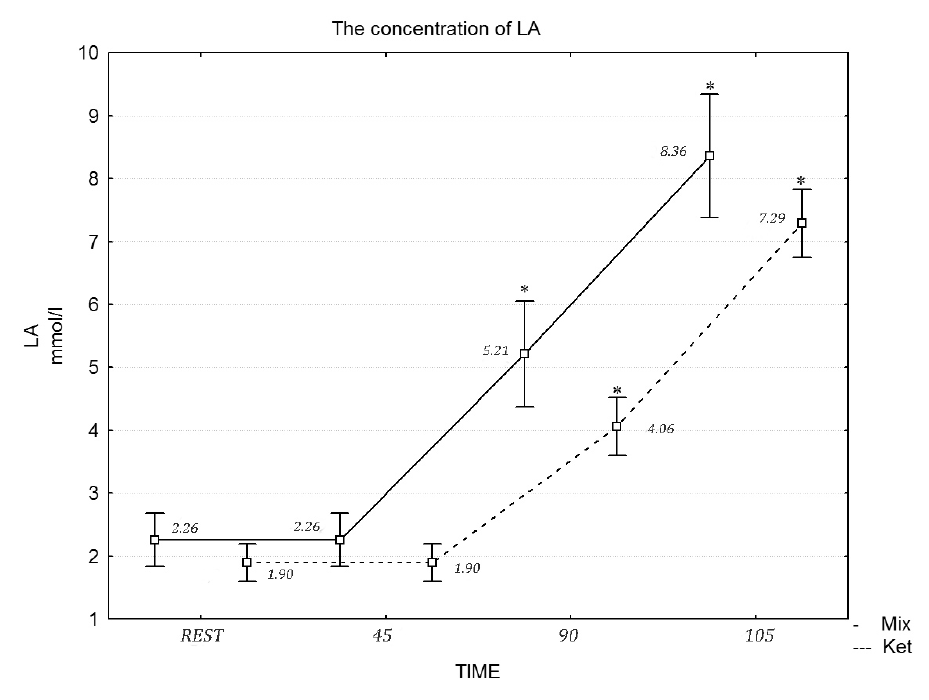
Figure 2. The concentration of LA during the exercise protocol, after a mixed and ketogenic diet. * Statistical significance with p <